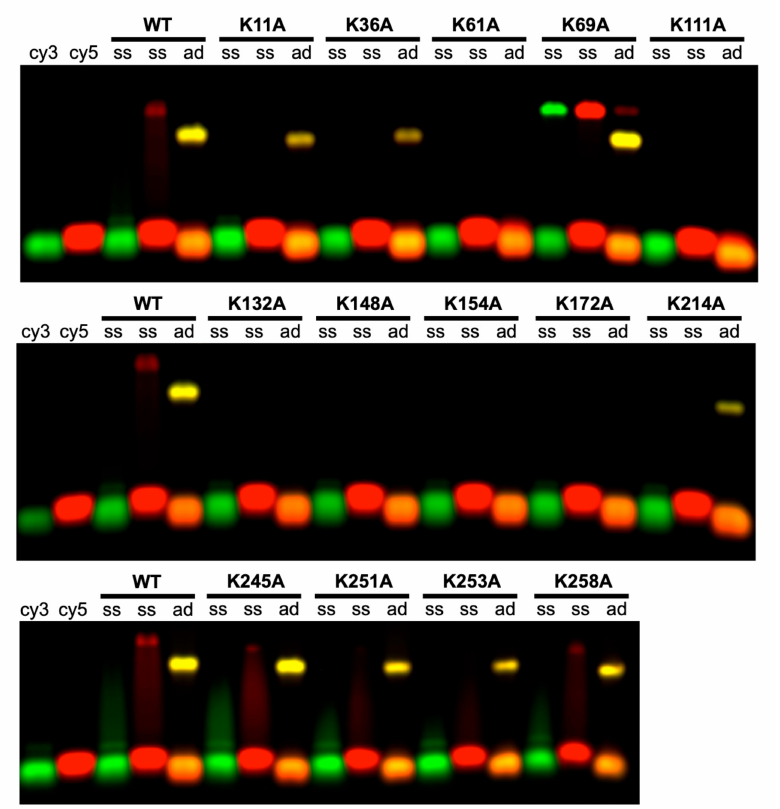
Figure 3. Gel-based DNA binding and annealing assay for the 14 Lys to Ala variants. Lanes labeled “cy3” and “cy5” contain individual 50-mer oligonucleotides labeled at the 5’-end with either Cy3 or Cy5. Lanes labeled “ss” contain 10 µ M of Red β mixed with 50 µ M (nucleotides) of each individual nucleotide (Cy3 or Cy5). Lanes labeled “ad” contain Red β incubated with the two complementary oligonucleotides added sequentially to form the complex with annealed duplex. Notice that WT Red β interacts weakly if at all with each individual ssDNA (seen as faint bands with streaking) but forms a stable complex when the two complementary oligos are added to the protein sequentially (prominent yellow bands). Many of the Lys to Ala variants, however, do not form this complex. K69A is unique in having increased binding to ssDNA. Single channel exposures for these gels showing each individual oligonucleotide (Cy3 or Cy5) are presented in Figure S6, to confirm that the yellow bands for the complex contain both